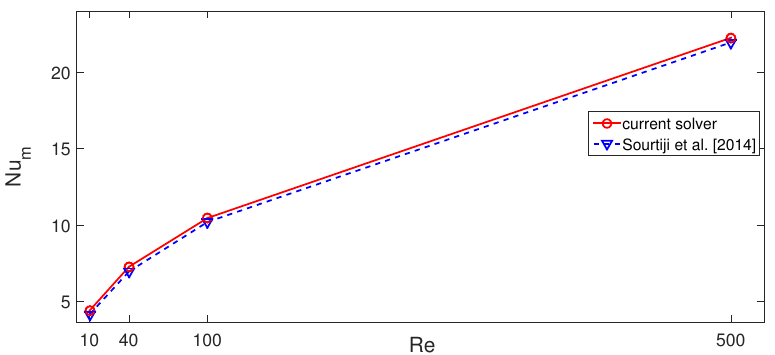
Figure 4. Average Nu number comparisons (with results of [14]) for different Re numbers, when convective HT in a vented cavity was